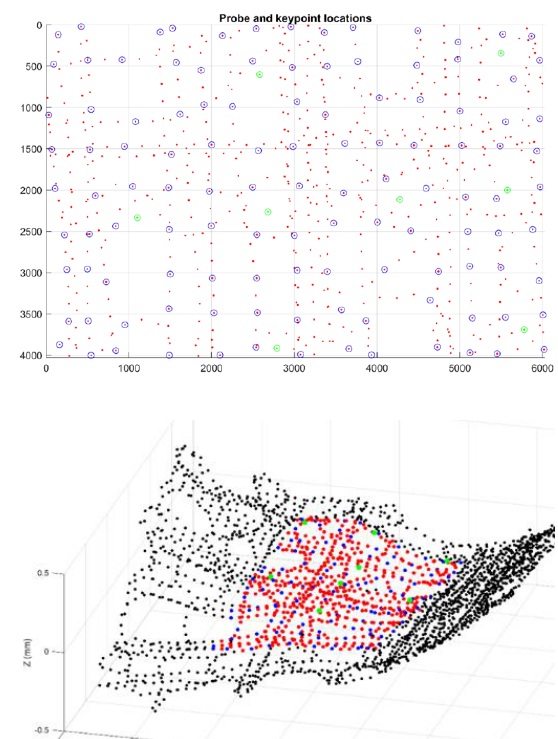
Figure 9. Top: Probe (red) and target (green) measurement coordinates within the image, and selected key points (blue). Bottom: Exaggerated Z axis plot of probe points on Reference Plate. Red points are within image area. Green points are targets. Blue points are the selected key points.